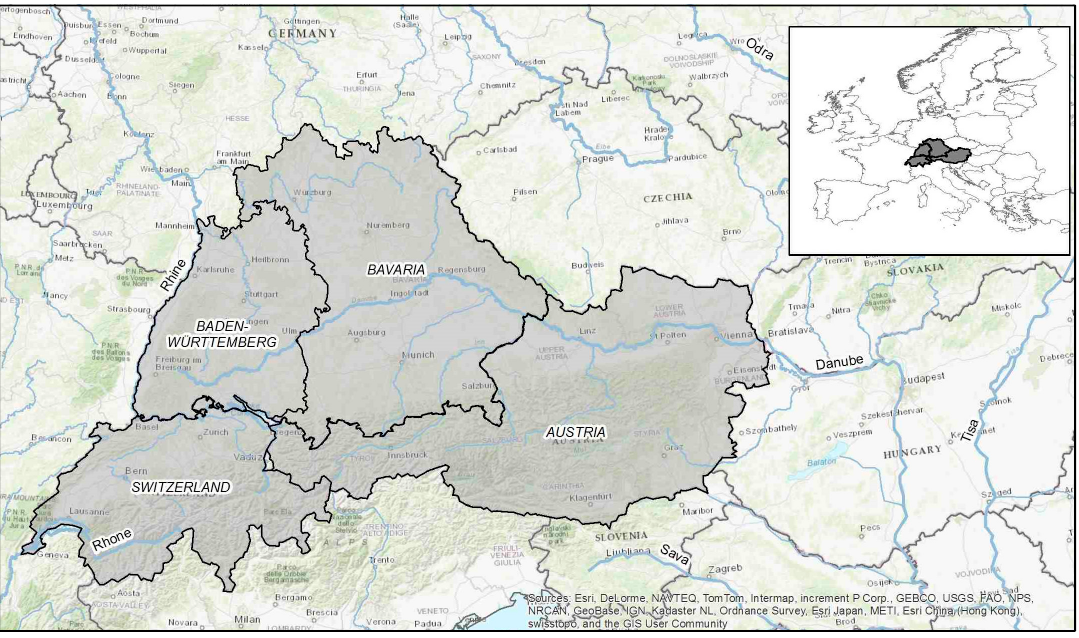
Figure 1. Overview of the case study regions Austria, Switzerland and Southern Germany (Bavaria and Baden-Württemberg).